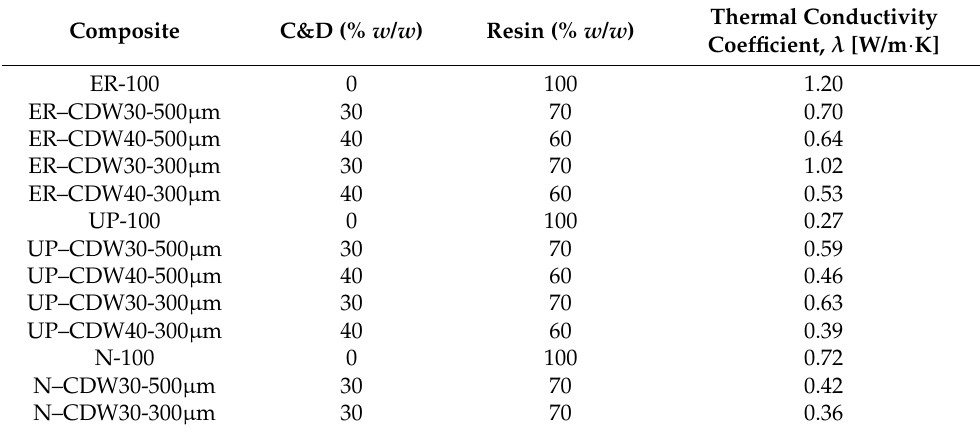
Table 4. Epoxy, unsaturated polyester, and novolac resin composites thermal conductivity coeffi- cient λ